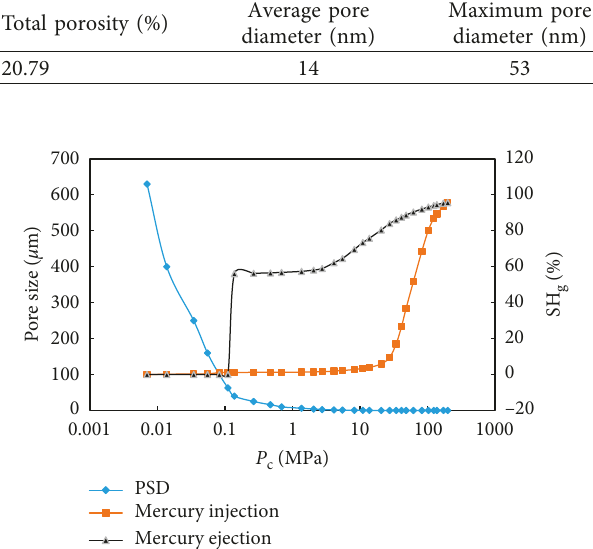
Figure 5: Capillary pressure curves. P pressure.